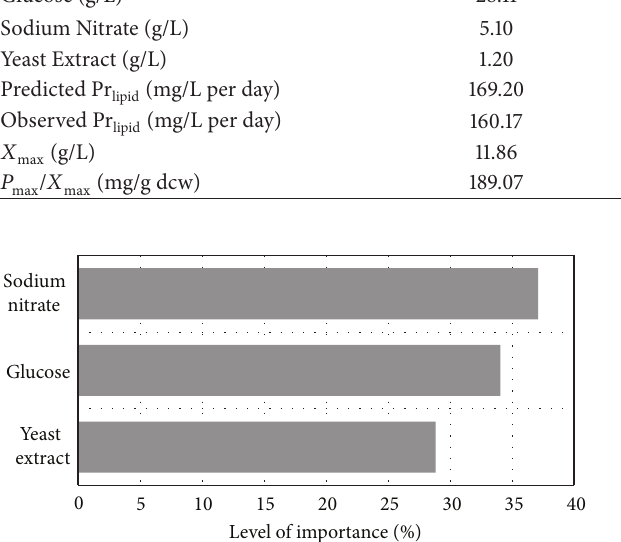
Figure 5: The level of importance of effective medium constituents on lipid